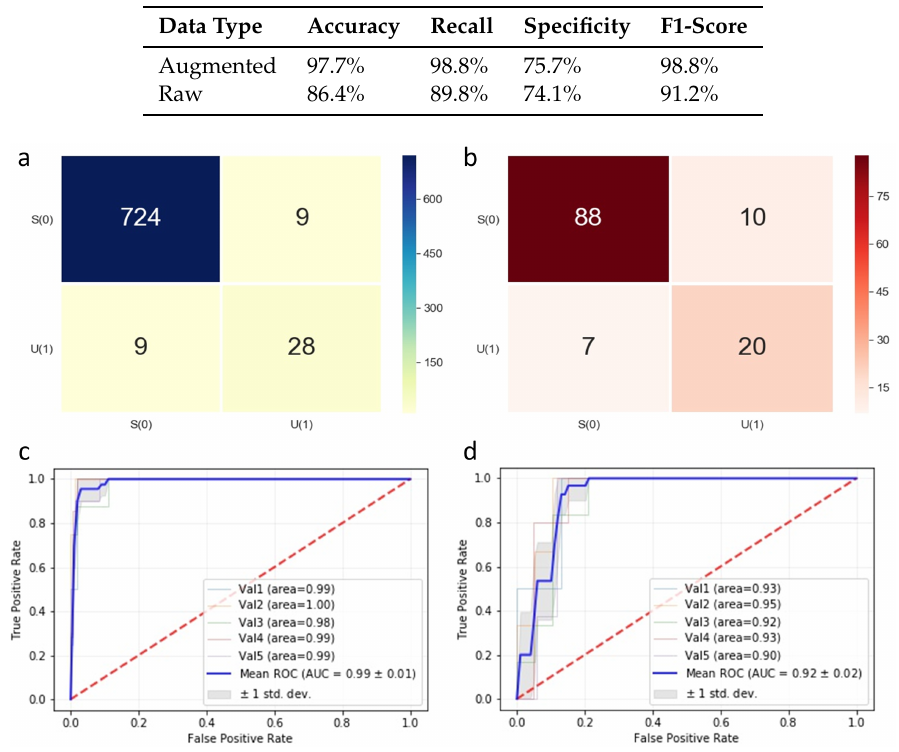
Figure 7. ( a ) Confusion matrix and ( c ) ROC for augmented data, ( b ) confusion matrix and ( d ) ROC for raw